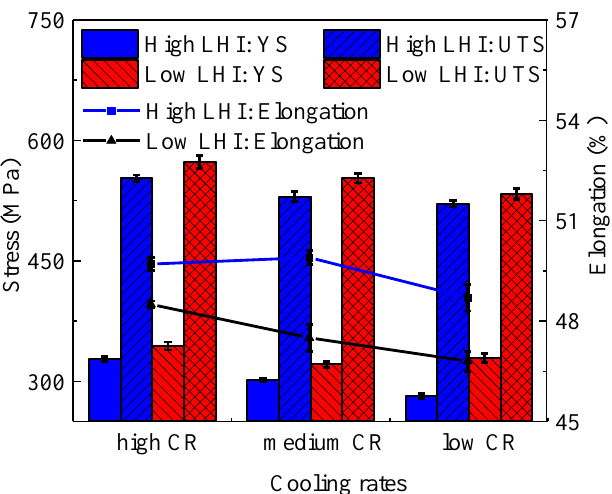
Figure 7. Engineering stress–strain relationships of the studied steel under: ( a ) low LEI, ( b ) high LEI.